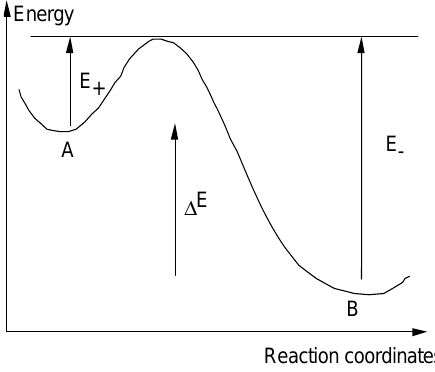
Figure 26. Relationship between activation energies.